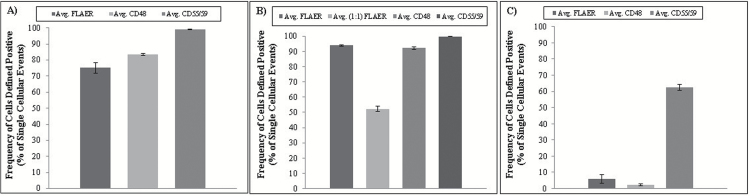
Average cellular surface marker expression within AHH-1, MCL-5 and low passage TK6 cells. FLAER–Alexa Fluor 488™ conjugate, CD48 phycoerythrin conjugate and CD55/59 phycoerythrin conjugate fluorescent dyes utilised to estimate surface marker expression. (A) AHH-1, (B) MCL-5 and (C) low passage TK6 cells (~10 000 single cellular events; n = 3, error bars ±1 SD).